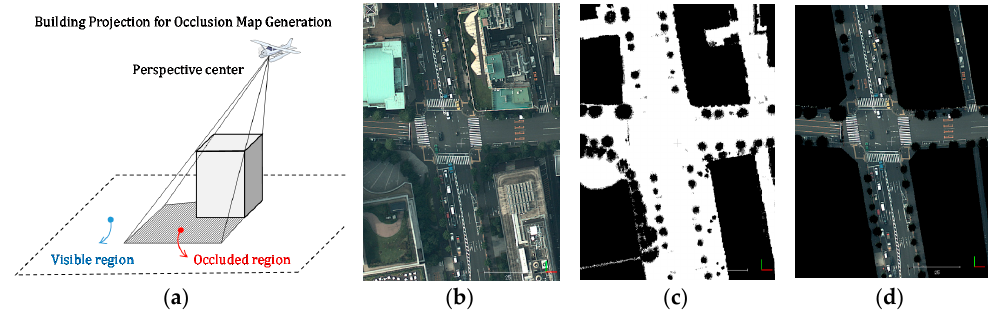
Figure 5. Generation of POM from the DSM: ( a ) overview of the buildings’ perspective occlusion map generation; ( b ) original aerial image; ( c ) generated POM; and ( d ) filtered result of the aerial image.